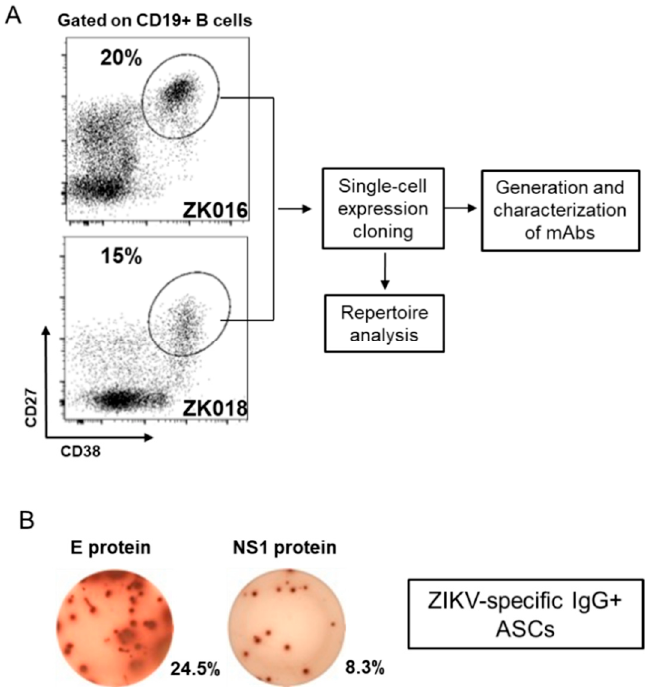
Figure 2. Virus-specific plasmablasts appear in circulation early after ZIKV infection. ( A ) Flow cytometry plots showing patient plasmablast (CD3 − CD19+ CD20 − /low CD38high CD27high) frequencies as a fraction of total CD19+ B cells. PBMCs were isolated from whole blood collected from patient ZK016 (7 DPO) and patient ZK018 (8 DPO) for flow cytometry analysis and plasmablast sorting. The workflow chart follows the generation and characterization of mAbs from single-cell sorted plasmablasts. ( B ) Representative ELISpot showing ZIKV E protein and NS1 protein-specific antibody secreting cells (ASCs). The wells shown contain 7 DPO PBMCs from patient ZK016. The percentages beside the wells represent the frequency of antigen-specific ASCs relative to the total number of IgG + ASCs.